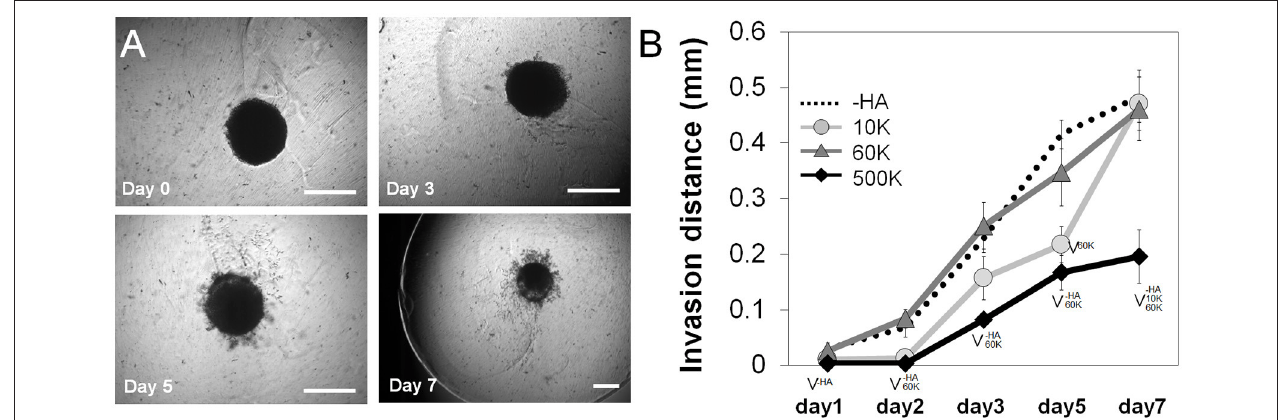
FIGURE 3 | (A) PDX invasion ( n 6) into the surrounding hydrogel was quantified via a spheroid assay throughout the 7-day culture period. Representative images of = spheroid invasion throughout the 7 day culture, showing GBM cells progressively leave the spheroid and invade the hydrogel. Scale bar 0.5mm. (B) Quantification of GBM cell invasion into the GelMA hydrogel as a function of the molecular weight of matrix immobilized HA. GelMA only (–HA) and GelMA hydrogels containing 60 kDa (60K) HA showed the greatest levels of invasion, with no significant difference between those groups across the culture period. Interestingly, GelMA hydrogels containing high molecular weight HA (500K) showed significantly reduced invasion. ∨ p < 0.05 significant decrease between groups.